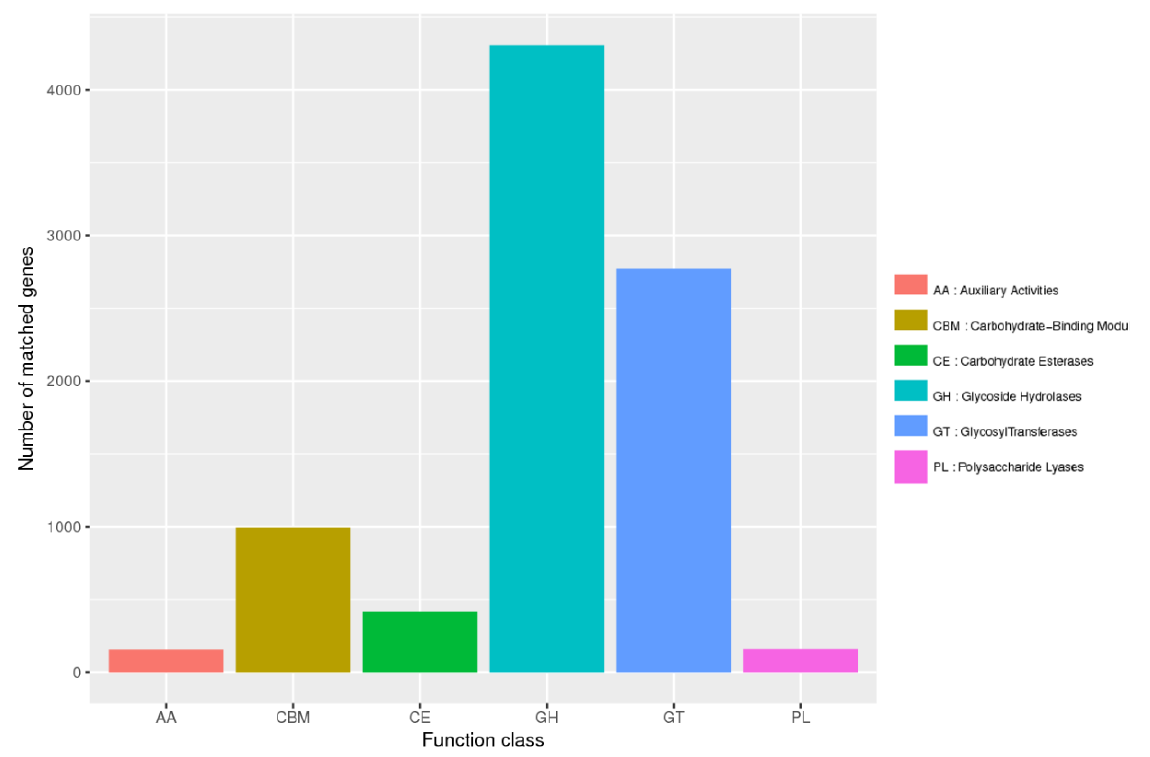
Figure 3. Metagenomic contigs mapped to CAZy family genes.